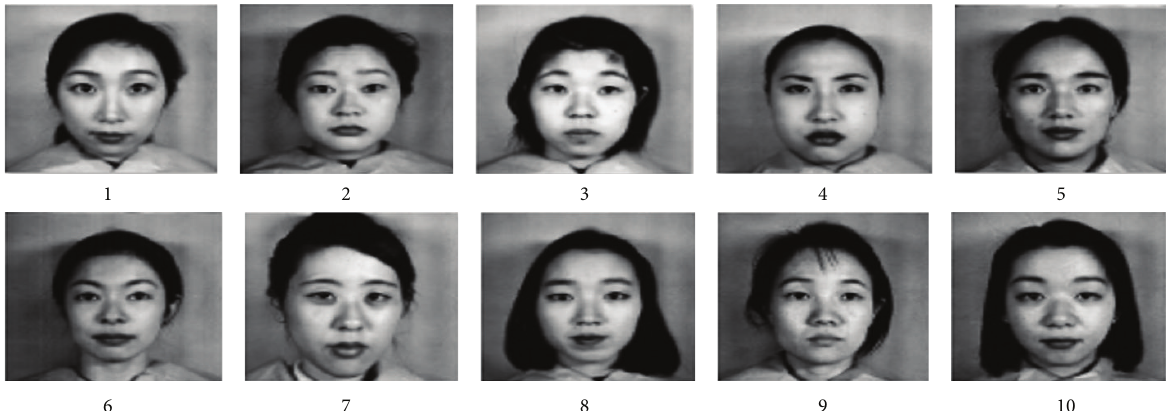
Figure 5: Database images (only neutral face images of 10 subjects are stored in database which helps to reduce the stored